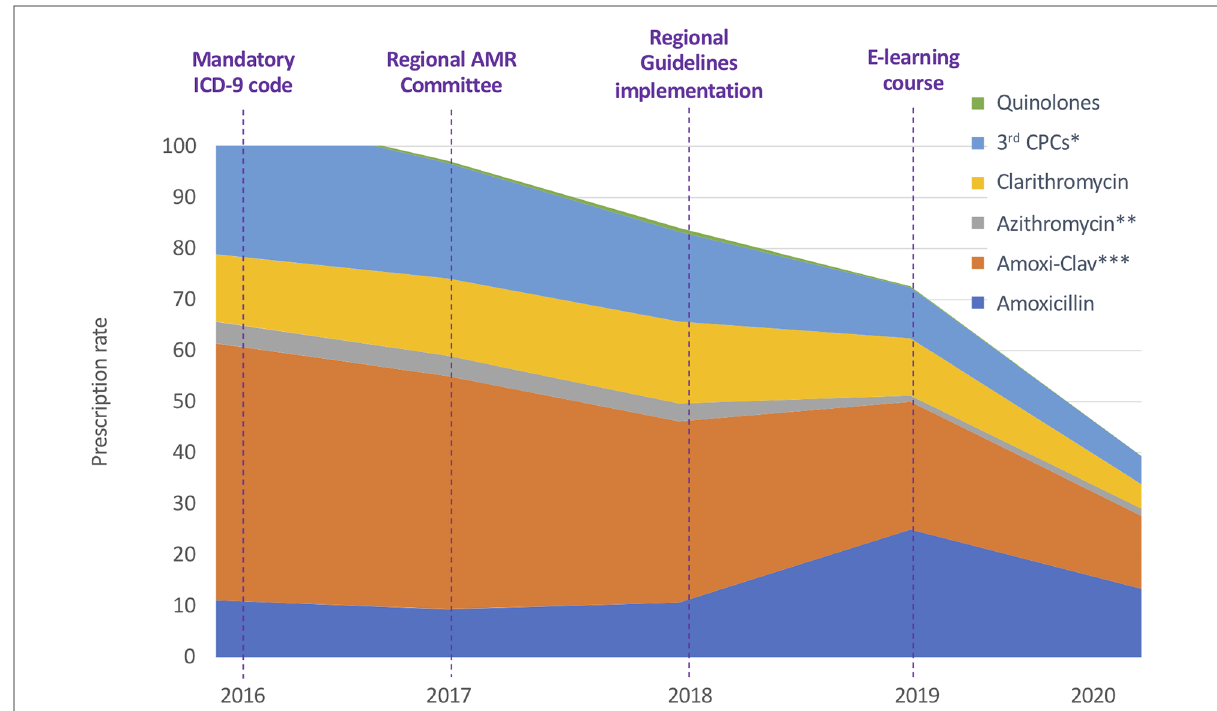
FIGURE 2 Annual antibiotic prescription rates for speci fi c antibiotics classes and molecules. ICD-9: International Classi fi cation of Diseases-9. AMR, Antimicrobial Resistance. 3rd CPCs: third generation Cephalosporins. * p <0.001. ** P =0.029. *** p